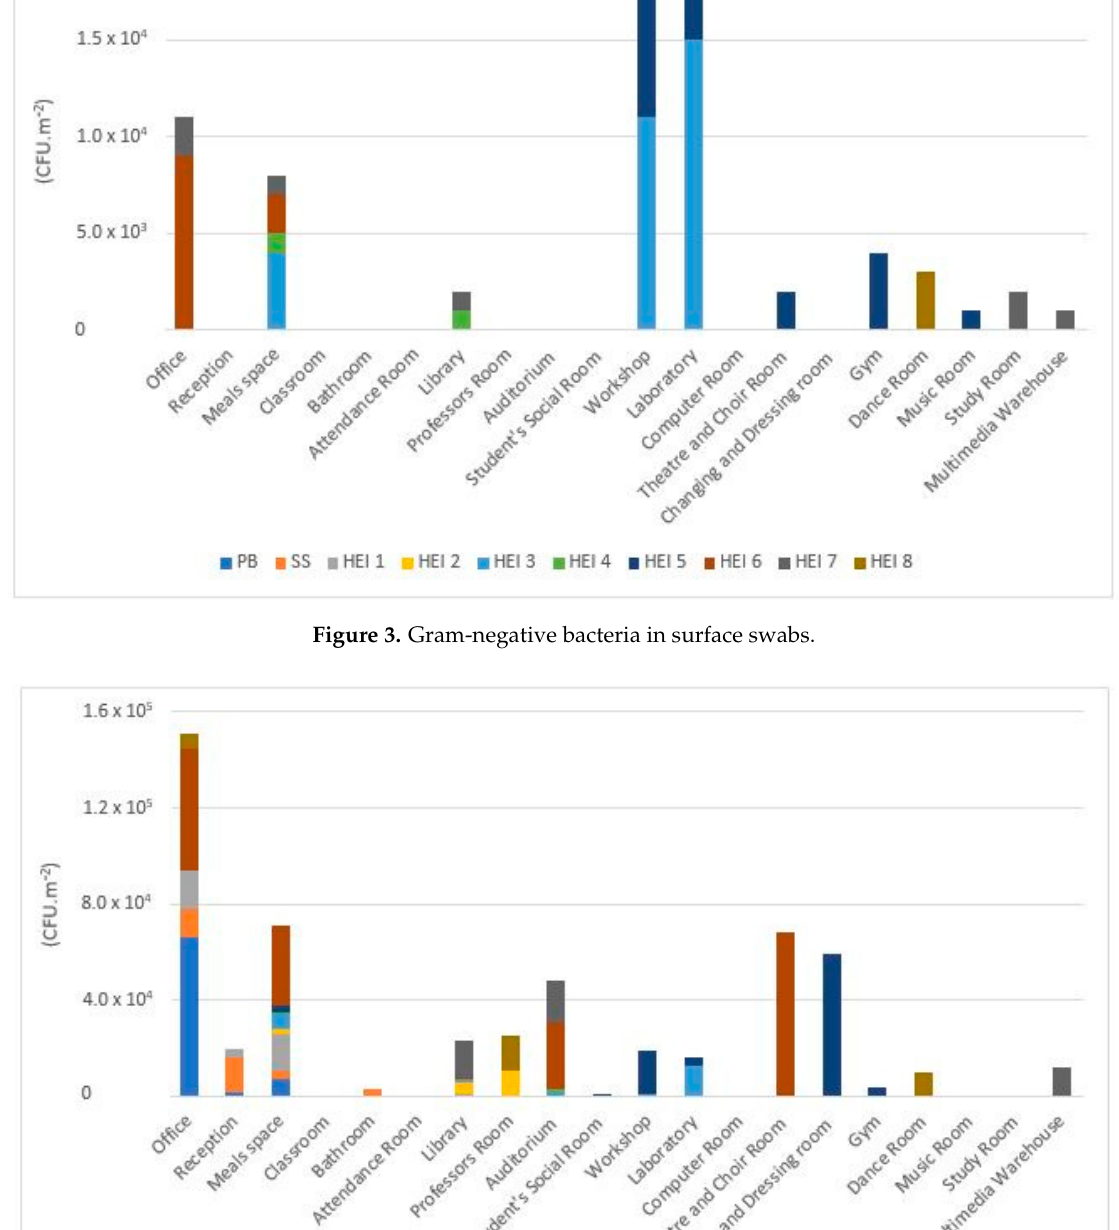
Figure 3. Gram-negative bacteria in surface swabs.